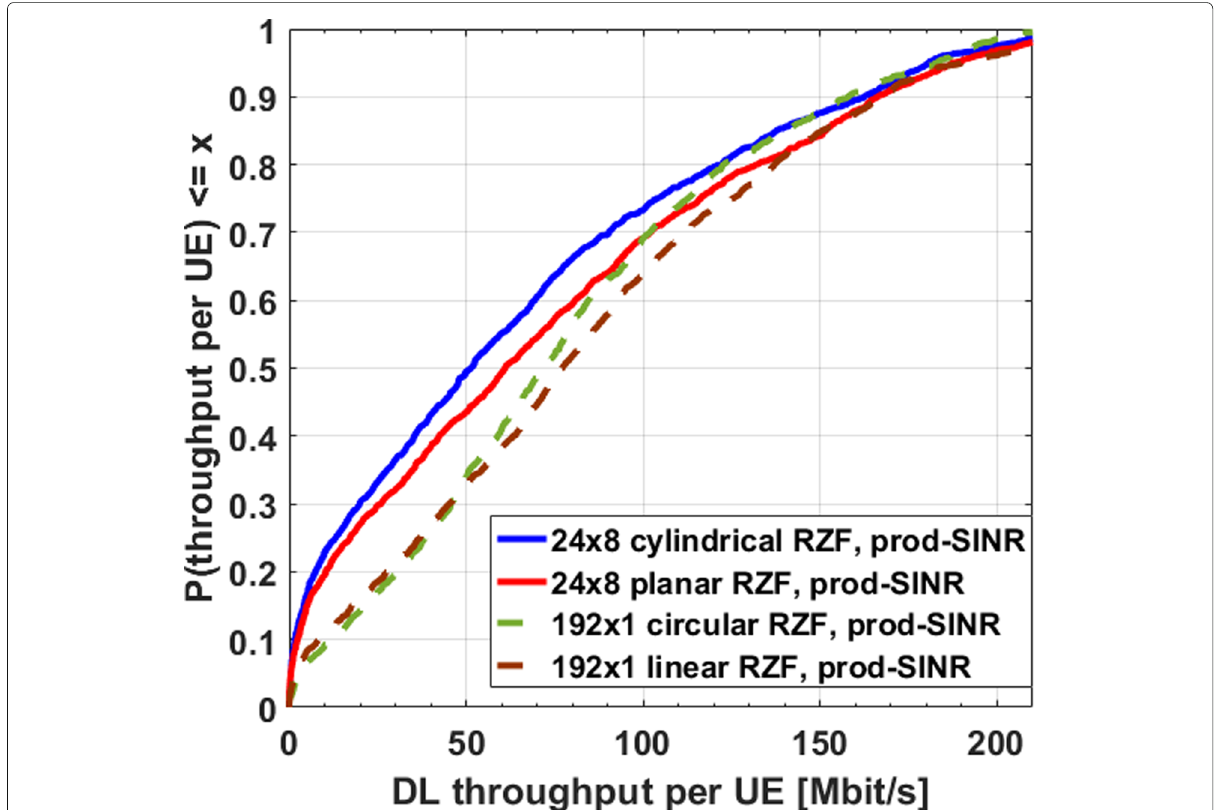
Fig. 10 DL throughput per UE for different antenna configurations considering regularized zero-forcing precoding and prod-SINR power control optimization